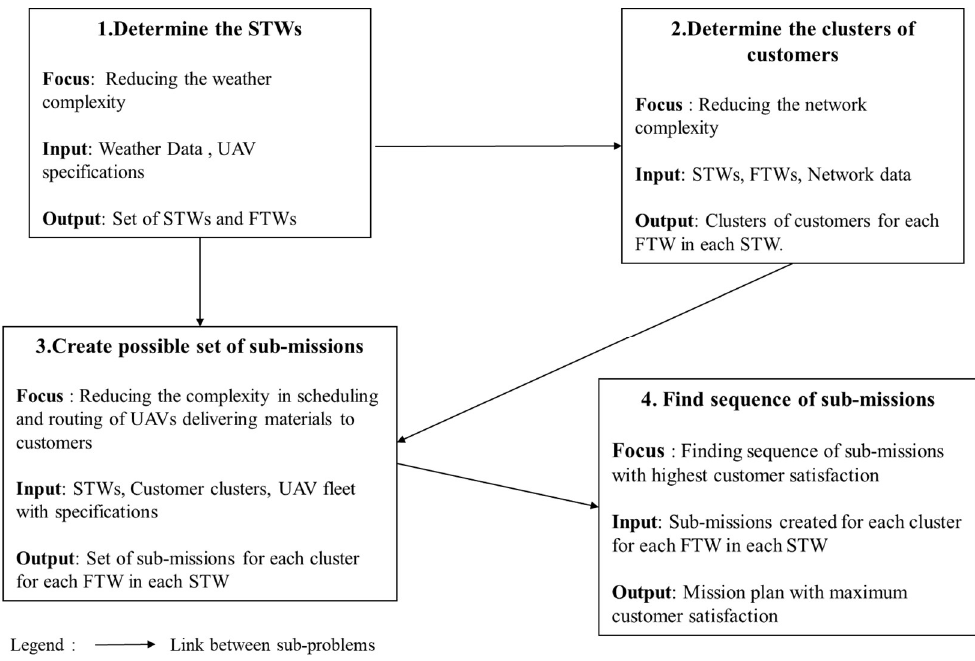
Figure 2. Interdependency between the decomposed sub-problems.